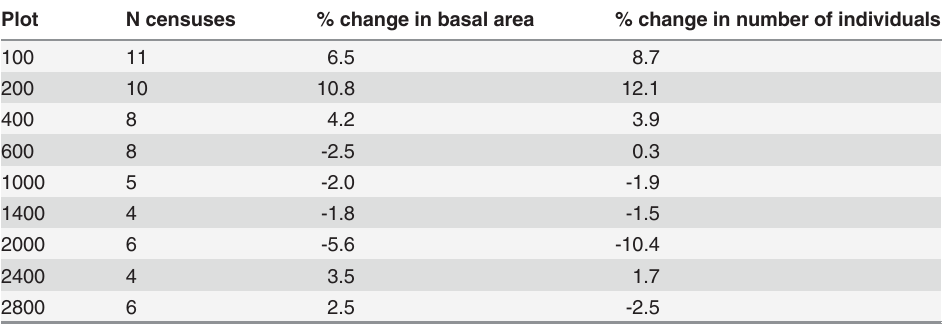
Table 6. Temporal trends in